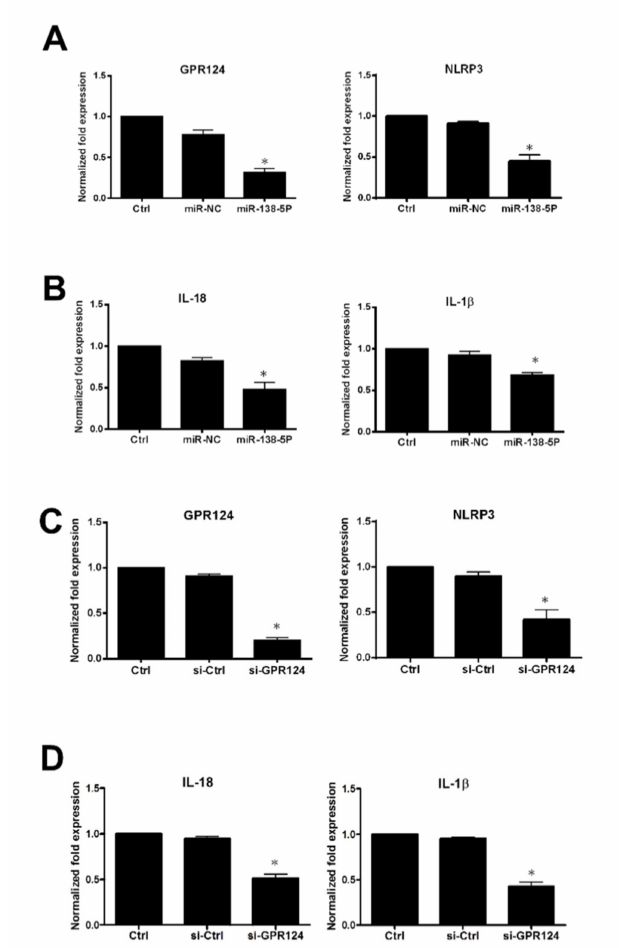
Figure 5. The excessive activation of NLRP3, IL-18, and IL-1 β inflammasome in spontaneous miscar- riage compared to normal pregnancy. Human primary endometrial stromal cells were transfected with miR-138-5P (25 nM) and si-GPR124 (50 nM) for 48 h. The endometrial stromal cell medium was collected at 48 h after transfection to assess IL-1 β , IL-18, and NLRP3 levels. ( A ) The expressions of GPR124 and NLRP3 mRNA regulated by miR-138-5p in endometrial stromal cells. ( B ) The ex- pressions of IL-18 and IL-1 β mRNA regulated by miR-138-5p in endometrial stromal cells. ( C ) The expressions of GPR124 and NLRP3 mRNA regulated by si-GPR124 in endometrial stromal cells. ( D ) The expressions of IL-18 and IL-1 β mRNA regulated by si-GPR124 in endometrial stromal cells. miRNA negative control (miR-NC). siRNA control (si-Ctrl). (* p < 0.05, versus control).